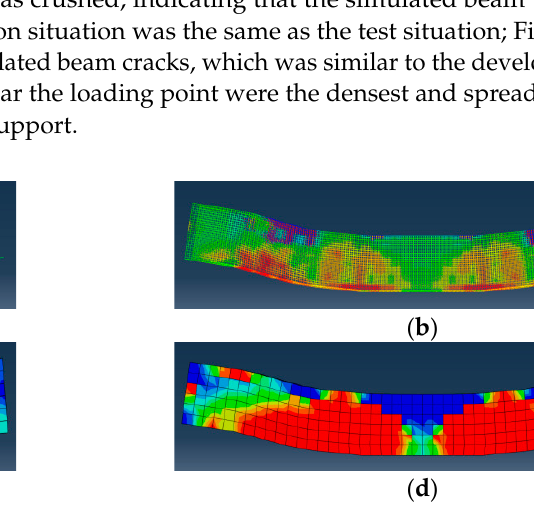
Figure 14. Stress contours and damage contours. ( a ) The stress contours of the steel frame when the specimen yields under tension; ( b ) the stress contours of the steel wire mesh when the specimen yields under tension; ( c ) stress contours when concrete is crushed in the compression zone; ( d ) the damage contours of the concrete when the specimen yields under tension.